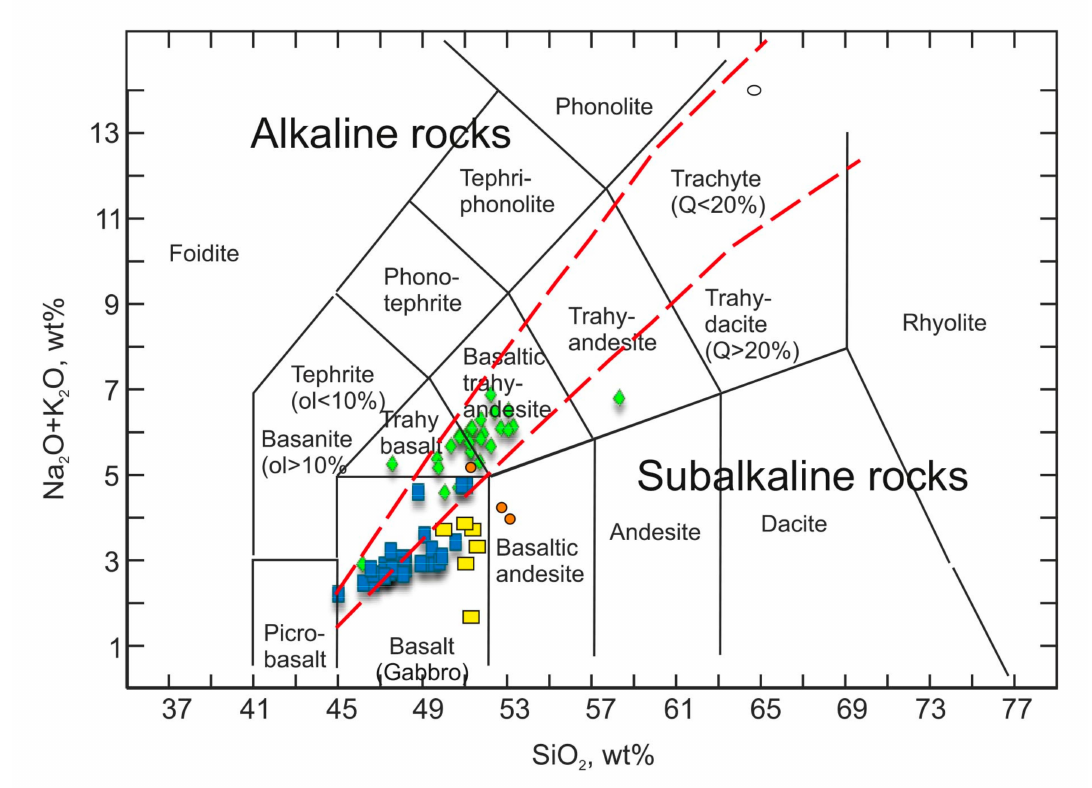
Figure 18. Comparative diagram of SiO 2 vs Na 2 O + K 2 O for various intrusive complexes of the Norilsk district. Data for the Ergalakh (green diamonds) and Norilsk (blue squares) rocks are given in Table S1 and Table 1 (Turumakit area); data for Avamsky (yellow squares) complex after [16], Ivakinsky Formation (orange circles)—unpublished authors’ data. Red dashed lines are represented boundaries between alkaline and subalkaline rocks, according to